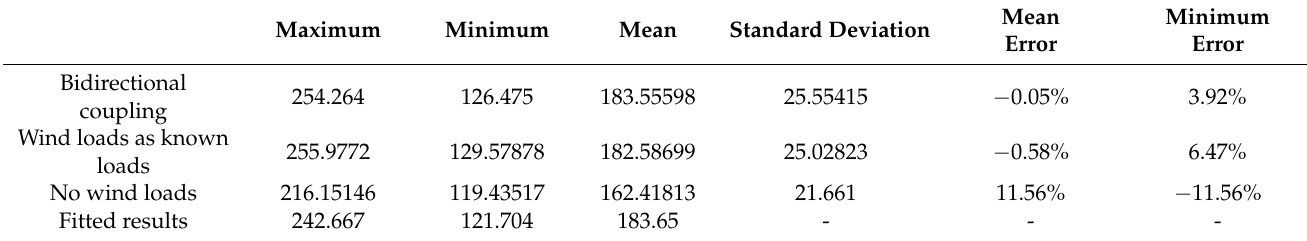
Table 1. Statistical results of contact force between pantograph and catenary simulated and fitted under open air at 360